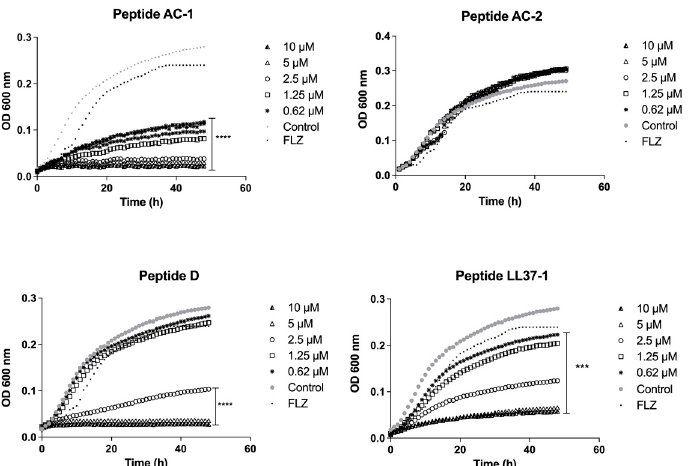
Figure 2. Growth curves of C. albicans 256. Four LL-37-derived peptides (AC-1, AC-2, D, and LL37-1) were tested at different concentrations (10, 5, 2.5, 1.25, and 0.62 µM). C. albicans 256 cells without exposure to antimicrobial peptides were used as a control. Fluconazole (64µg/mL) was used as antifungal control. Data represent three independent experiments. Statistical significance *** p < 0.001, **** p < 0.0001 when compared to control.